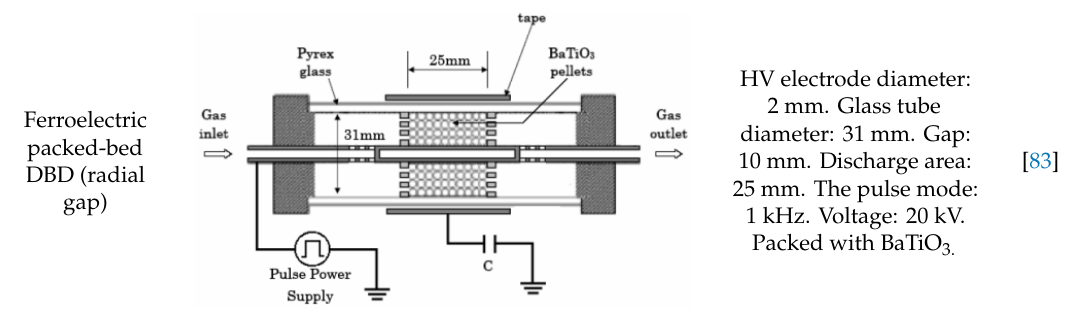
Table 6. Examples of plasma DRM reactors with ferroelectric materials and corresponding experimental conditions.